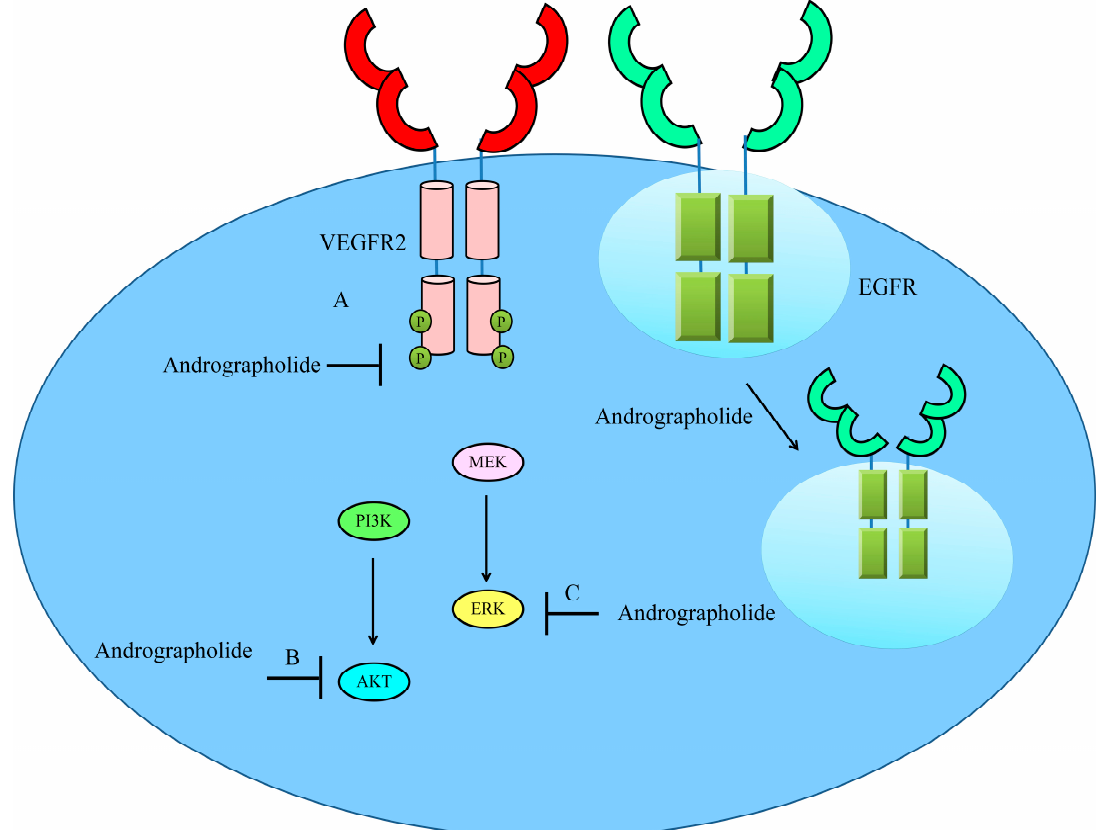
Figure 4. Schematic diagram of regulation of VEGF/VEGFR-driven pathway by andrographolide. Andrographolide effectively inhibited phosphorylation of VEGFR, AKT and ERK. Andrographolide also promoted internalization of EGFR to inhibit cell surface expression of EGFR and reduce EGF/EGFR-driven downstream signaling.